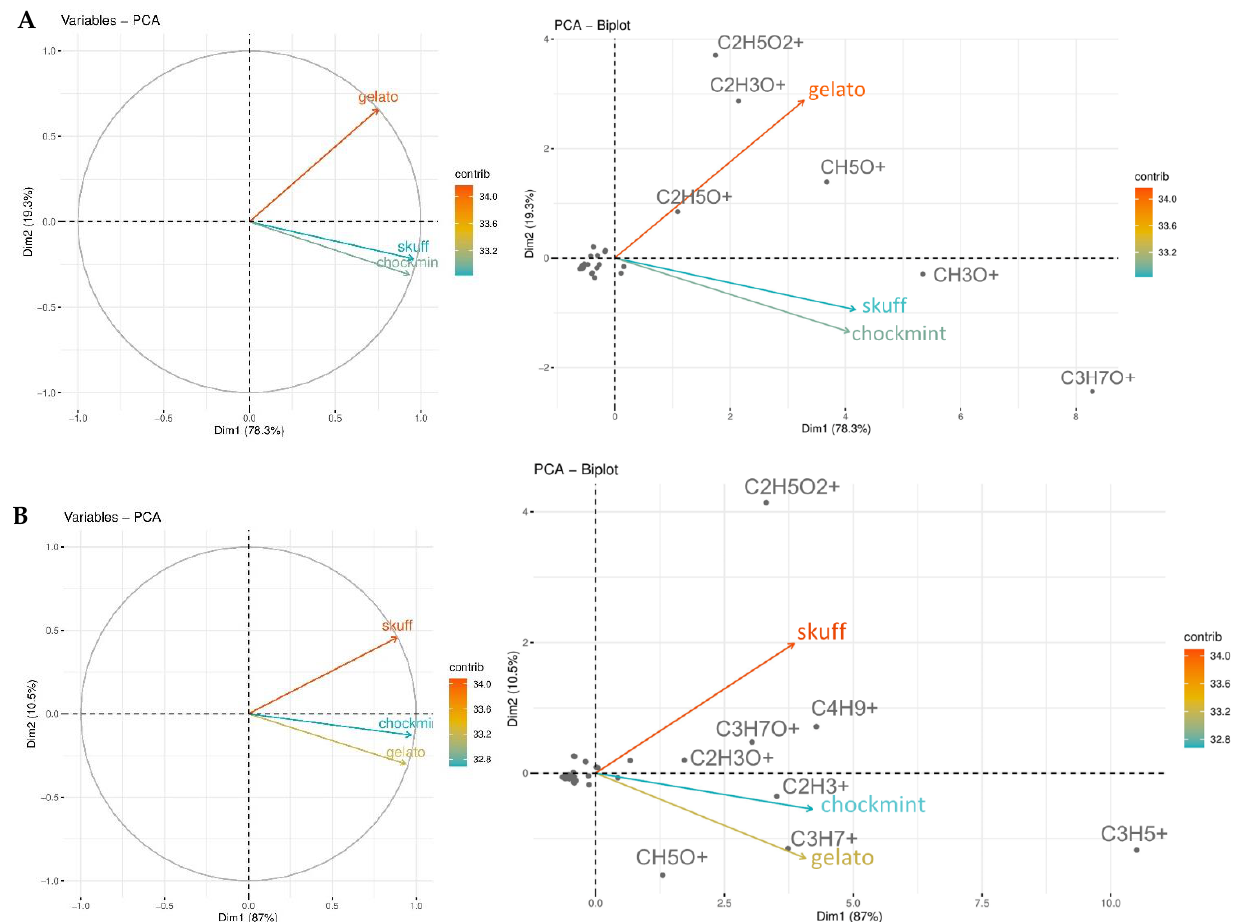
Figure 3. ( A ) Principal component analysis (PCA) for pollen C. sativa cultivars. Score plot and biplot provide information on both metabolites and samples of a data matrix to be displayed graphically. Metabolites grouped at the origin of the graph do not contribute to samples’ variability. ( B ) PCA score plot and biplot for pollen hexanoic extracts of C. sativa cultivars.